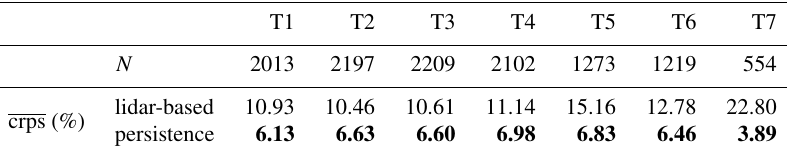
Figure 14. Reliability diagrams of all free-flow turbines of (a) the lidar-based forecast and (b) persistence for unstable stratification. The 95% confidence intervals are visualized as error bars. Table 4. Number of valid forecasts N and average crps for turbines T1–T7 for the probabilistic lidar-based forecast and persistence during stable and neutral stratification. The crps is given in percent of the turbines’ nominal power with the lowest values in